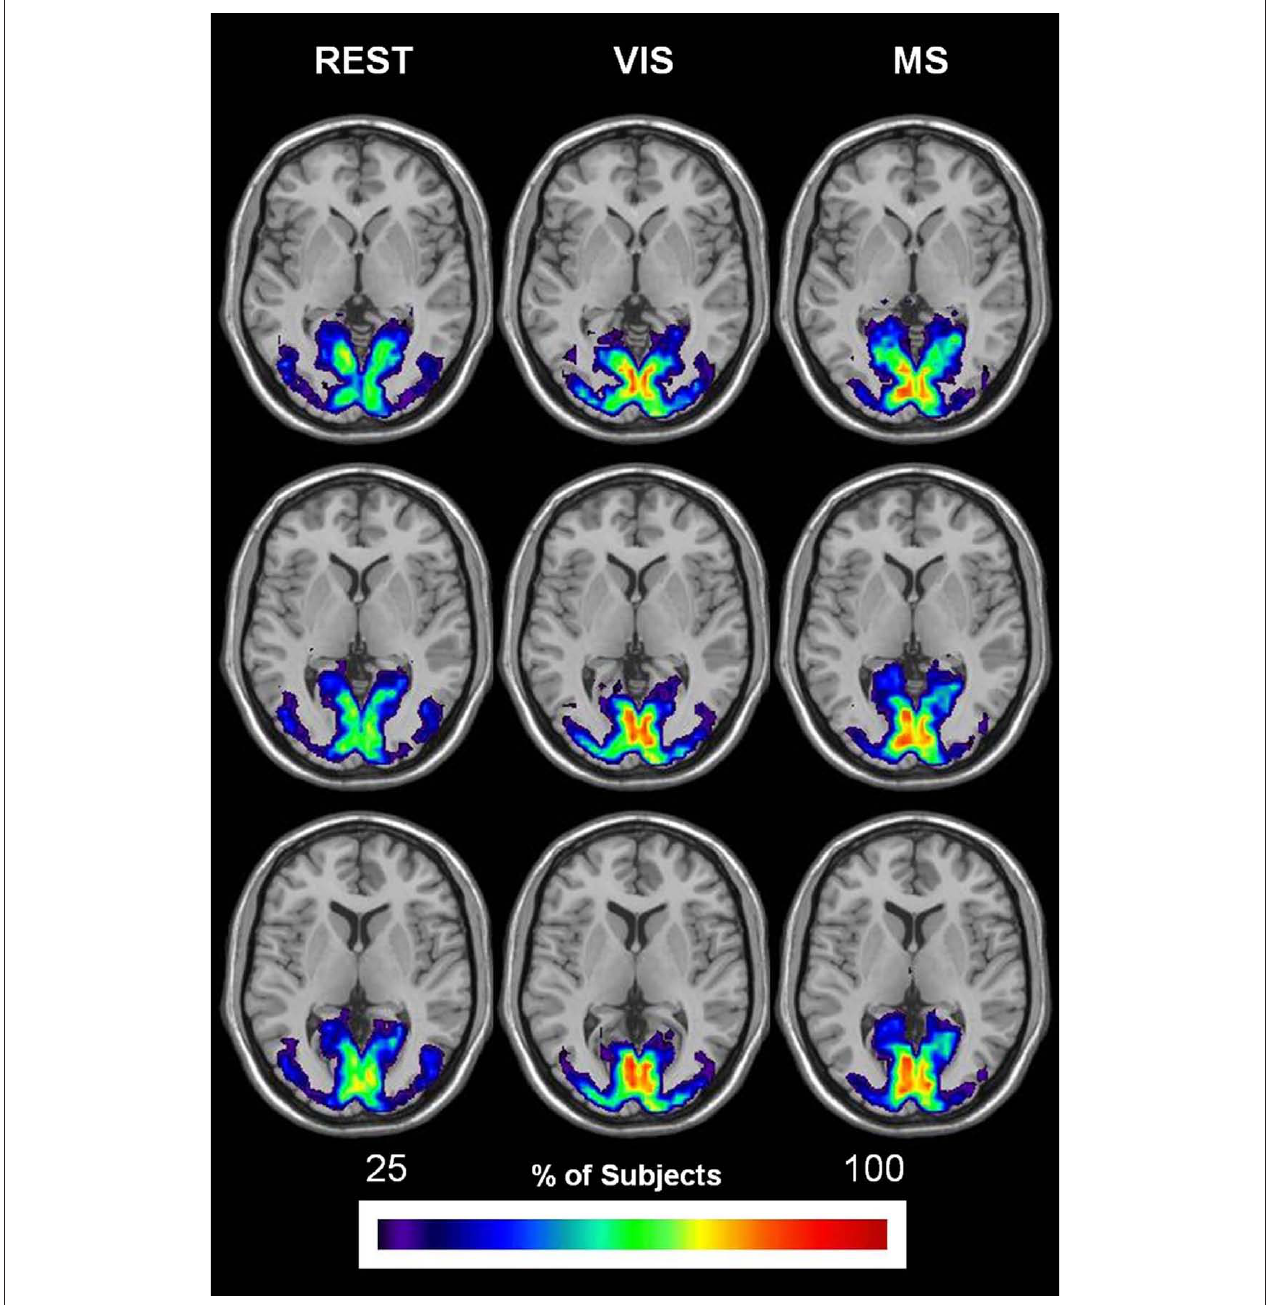
sulci, and the cuneus. The spatial extent of the visual module across task is shown to remain relatively the same in all three conditions: rest (REST), visual (VIS), and multisensory (MS). Group overlap or consistency, on the other hand, exhibits an increase in both the visual and